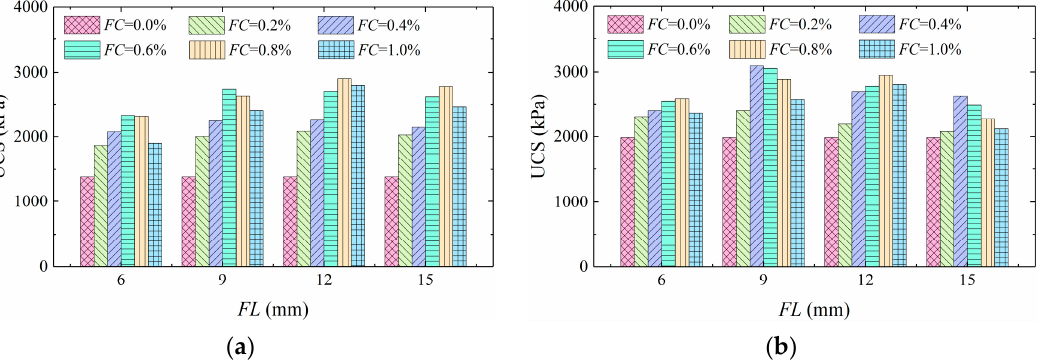
Figure 7. Histogram of unconfined compressive strength versus fiber length ( a ) ρ d = 1.5 g/cm 3 ; and ( b ) ρ d = 1.6 g/cm 3 .